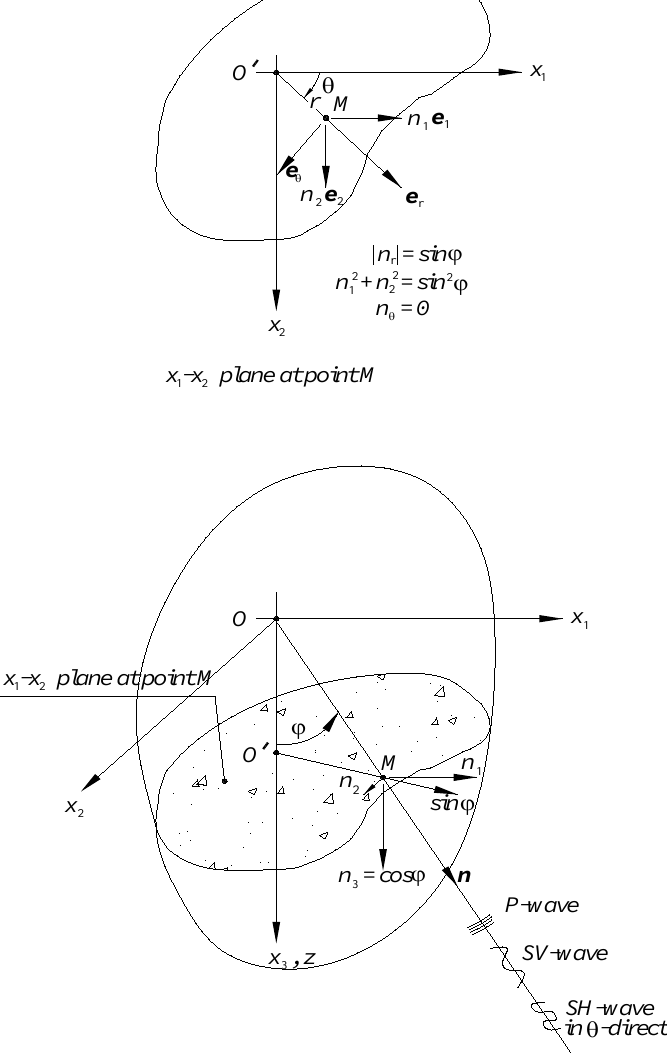
Fig. 1. A schematic illustration for showing P -, SV - and SH -waves traveling in the direction of n at a point M of a full-space occupied by transversely isotropic